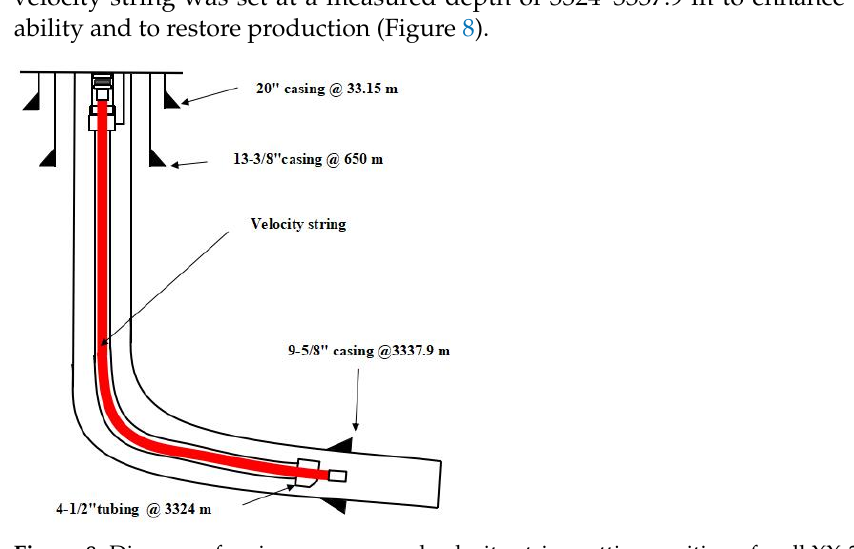
Table 3. Formation pressure at which fluid began to accumulate at different wellhead pressures for different pipe